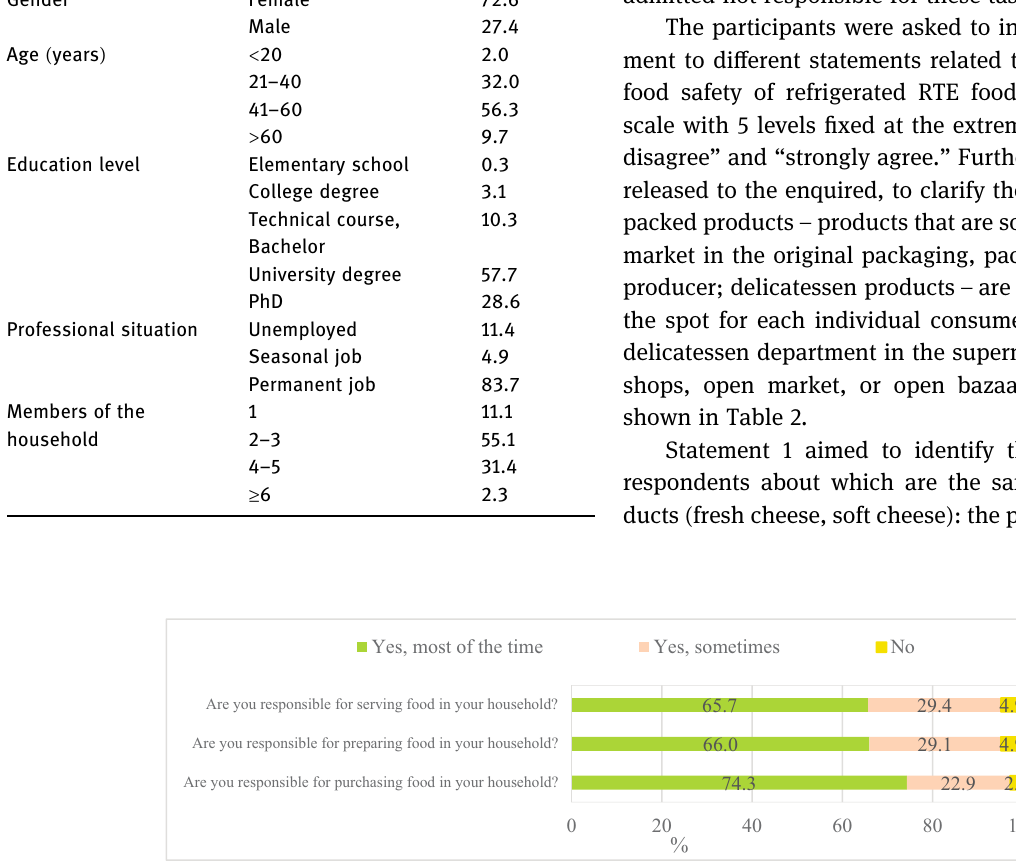
Figure 1: Participant ’ s responsibilities in their household related to